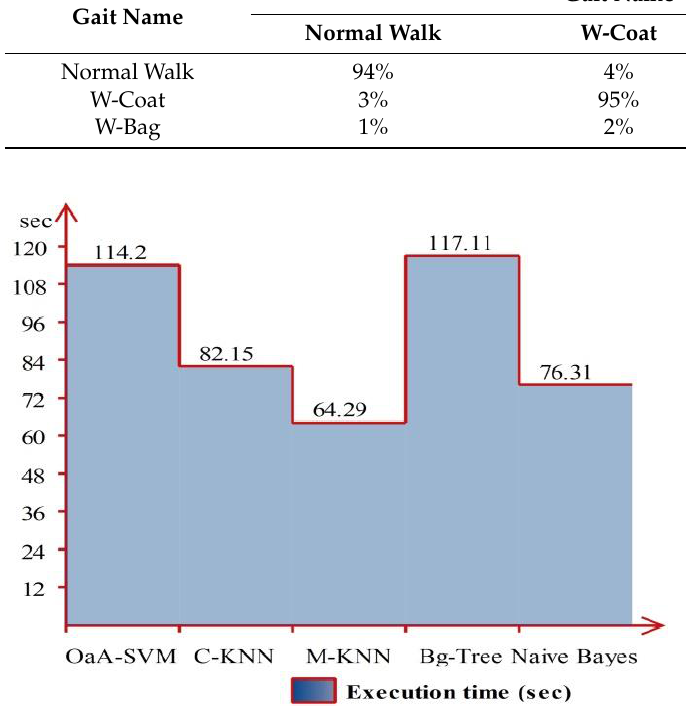
Figure 14. Execution time of proposed method for CASIA B dataset (90°